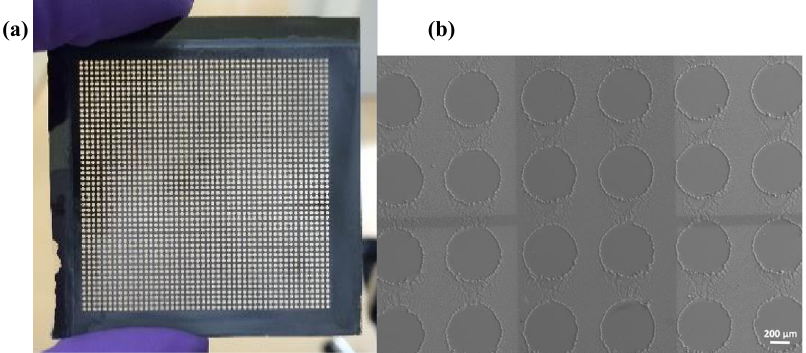
Fig. 2. (a) Glass/Mo substrate (5 (cid:3) 5cm 2 ) with laser patterned Mo back contact zone (4 (cid:3) 4cm 2 ) in the center after the electrodeposition of CIGS. (b) SEM details of the structured Mo surface with conformal CIGS cells giving the size of the holes of the